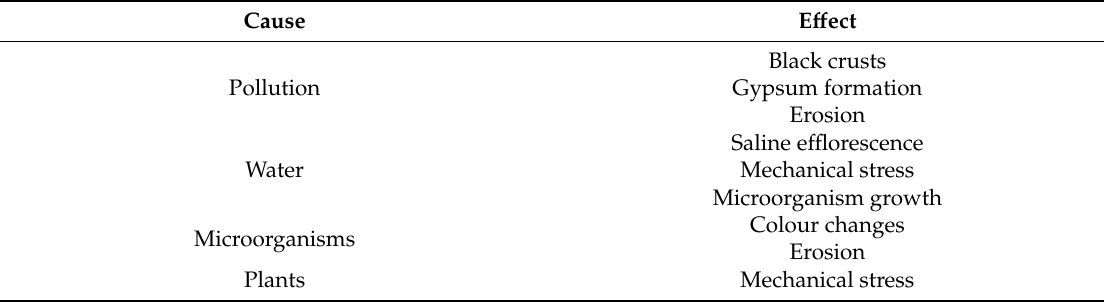
Table 6. Causes of limestone degradation and its e ff ects on the